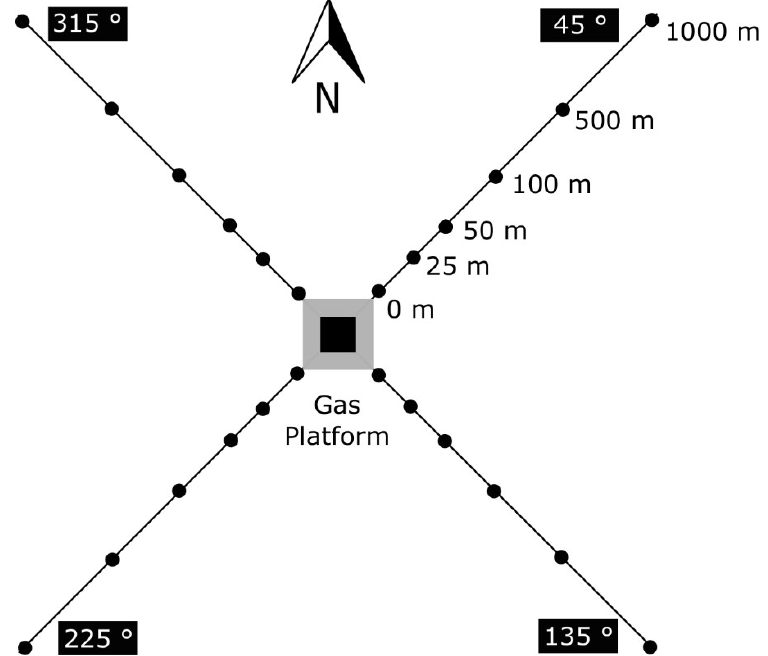
Figure 3. Sampling design for the two gas platforms.